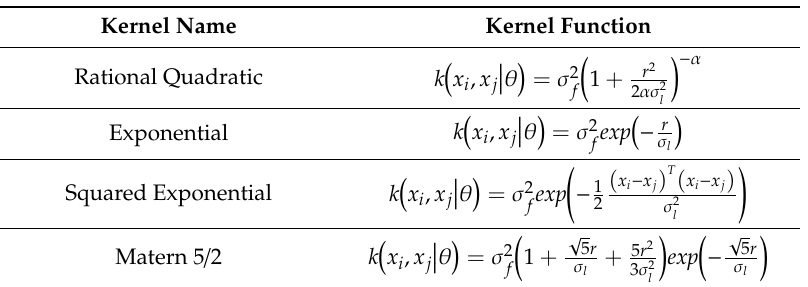
Table 2. Kernel functions for Gaussian process regression.